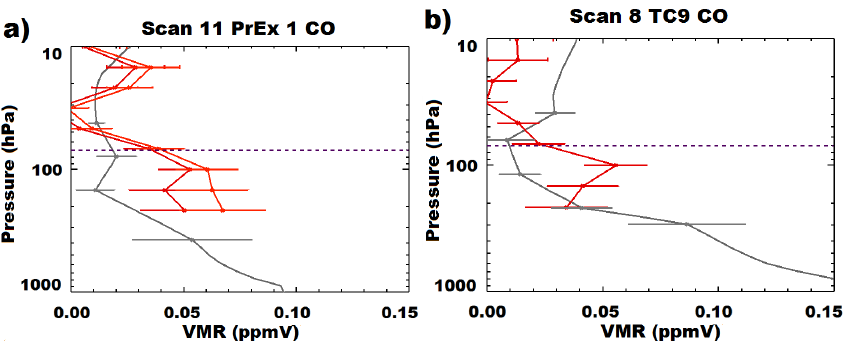
Fig. 16. (a) Comparison of CO profile retrieved from MARSCHALS scan 11 (grey) of PrEx 1 with MLS/Aura (red) CO profiles. (b) Comparison of CO profile retrieved from MARSCHALS scan 8 (grey) of TC9 with MLS/Aura (red) CO profiles. The horizontal dashed line represents the flight altitude level.